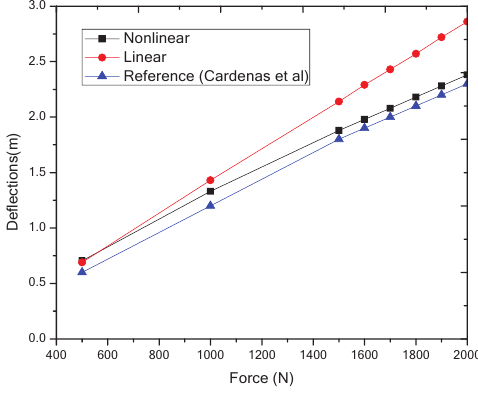
Figure 5. Finite element model showing the blade and the web